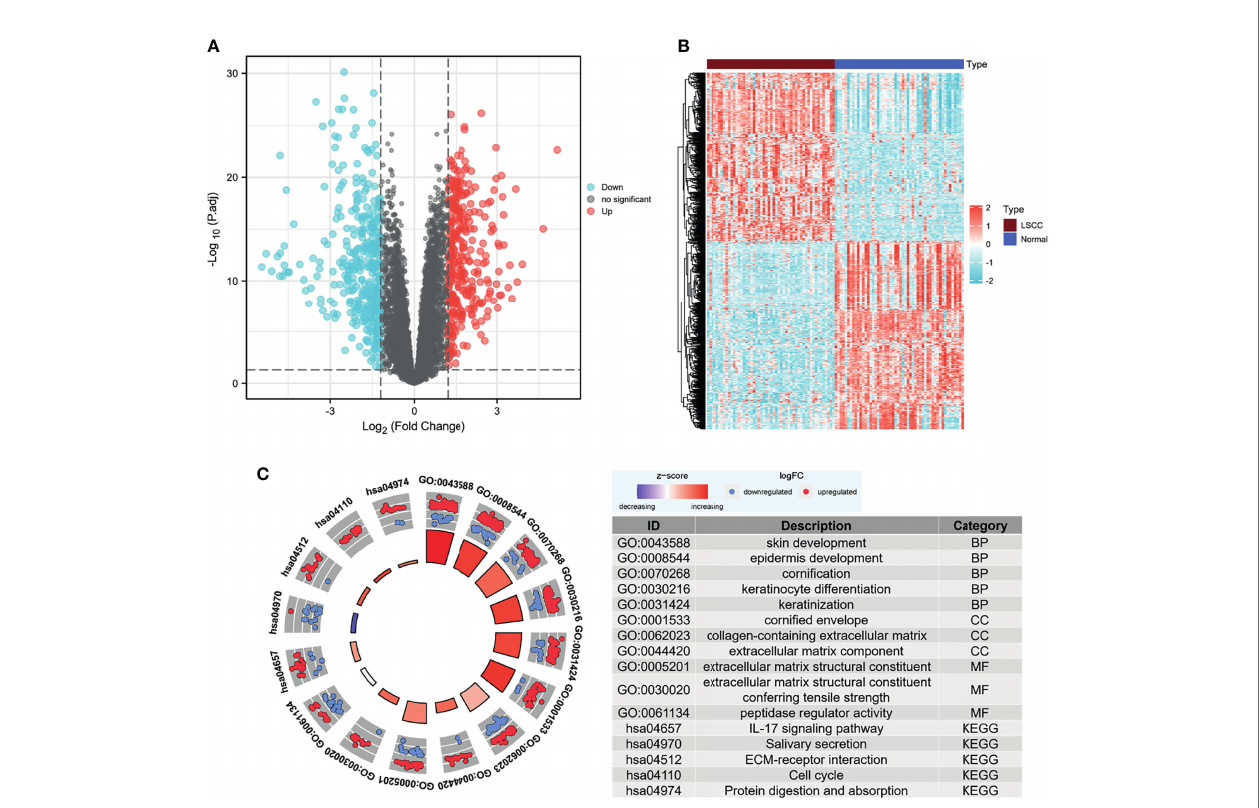
FIGURE 2 | Screening for DEGs. (A) Volcano map of DEGs between LSCC and normal samples in the GSE142083 dataset. The red plots in the volcano represent upregulated genes, and the blue points represent downregulated genes. (B) Heatmap of all the DEGs. The color in heatmaps from blue to yellow shows the progression from low expression to high expression, respectively. (C) GO and KEGG analysis of the DEGs. The outer circle shows the scatter plot of the assigned gene log 2 fold change for all terms: red points show genes that exhibited increased expression, whereas the blue points represent genes that exhibited decreased expression. The inner circle indicates the Z-score value and the number of genes: red represents the higher z-score value, and purple represents a lower Z-score value. DEG, differentially expressed gene; BP, biological process; CC, cell component; MF, molecular function; GO, Gene Ontology; KEGG, Kyoto Encyclopedia of Genes and Genomes; LSCC, laryngeal squamous cell